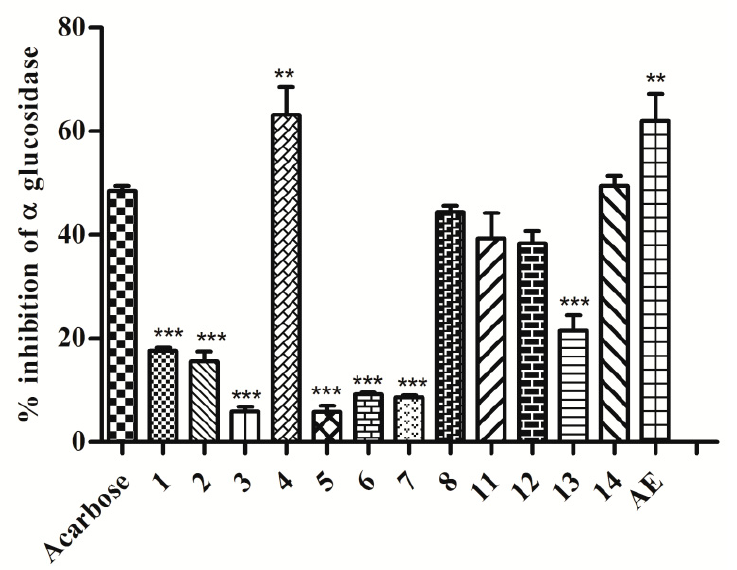
Figure 6. Intestinal α -glucosidase inhibitory assay. Compounds ( 1 – 8 ), ( 11 – 14 ), and acetone extract (AE) were incubated with α -glucosidase enzyme and the release of p -nitrophenol was determined. *** p < 0.001, ** p < 0.01; vs. Acarbose. One-way ANOVA followed by Tukey’s multiple comparison test was applied to compare differences. Values are represented as mean ± SD, n = 3. AE = Acetone Extract. Activity was not detected for compounds 9 and 10 .